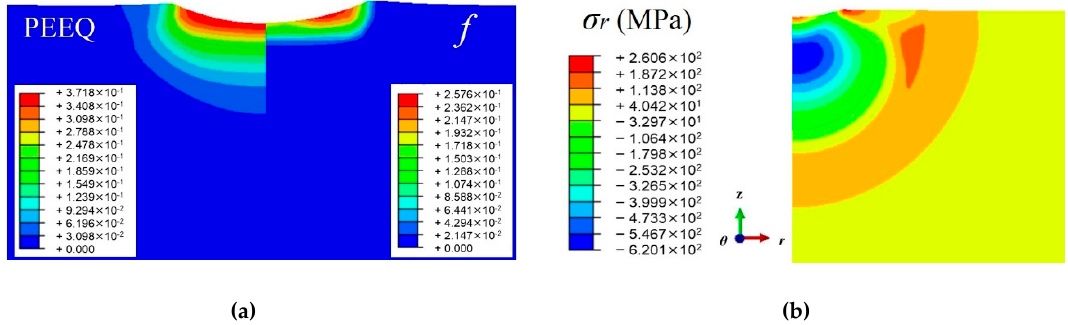
Figure 4. Distributions of ( a ) equivalent plastic strain (PEEQ) and martensitic volume fraction ( f ); ( b ) radial residual stress ( σ r ).